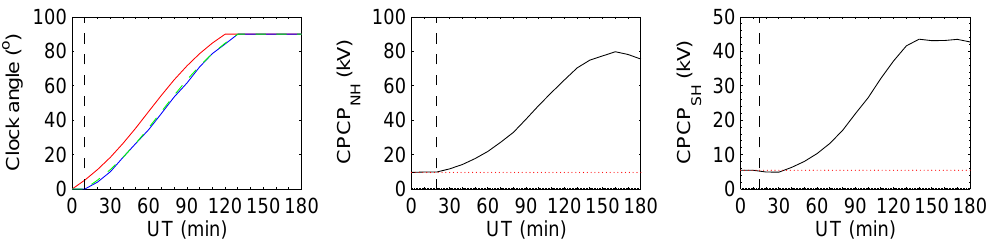
Fig. 2. The left column shows the time evolution of the clock angle defined as atan(B y /B z ) . Red line denotes the IMF clock angle at the 32 R E , blue denotes the IMF clock angle arriving at the magnetopause, green denotes that of the red line delayed by 10min. The middle and right columns show the time evolution of the cross polar cap potential in the Northern and Southern Hemispheres. The vertical dashed line indicates 20 (15)min after 00:00UT in the Northern (Southern)